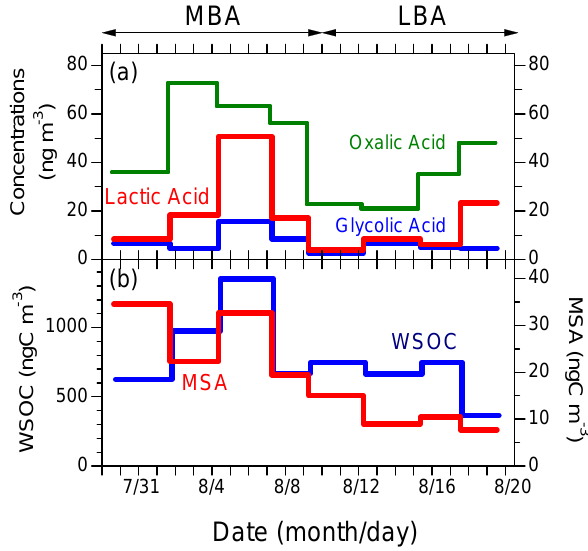
Figure 2. Time series of the concentrations of (a) lactic acid (LA) and glycolic acid (GA) in the particle phase compared with those of oxalic acid, (b) water-soluble organic carbon (WSOC), and methanesulfonic acid (MSA). The duration of LA and GA mea- surements was averaged over that of oxalic acid, WSOC, and MSA; measurements were performed with a cascade impactor every 2–3 days.